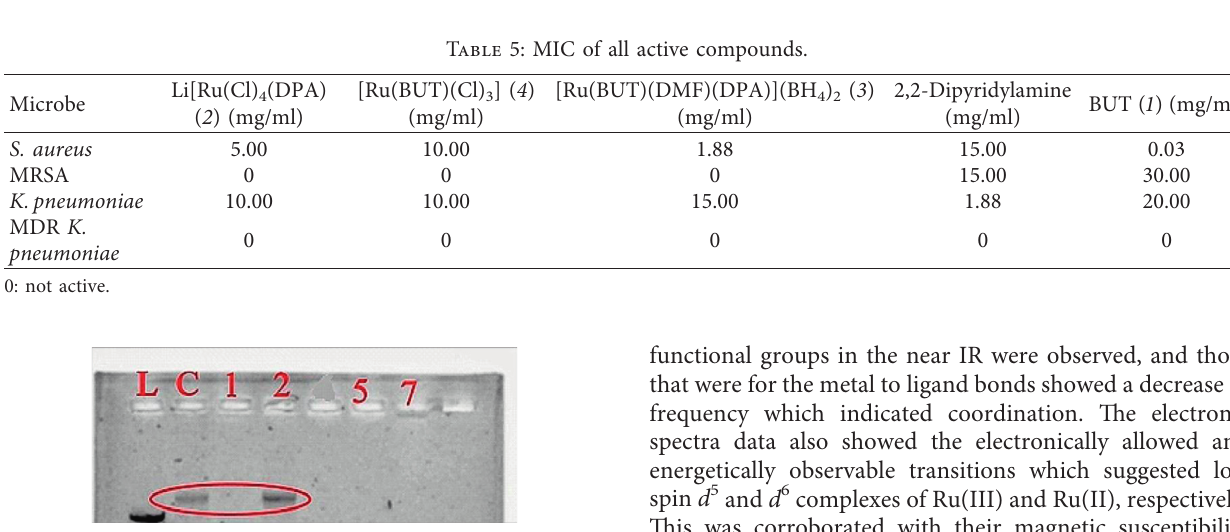
Figure 2: DNA cleavage analysis on 0.8% agarose gel. Lane L : 1 kb ladder; C : control DNA; 1 : complex 2; 2 : BUT; 5 : complex 4; 7 : complex 3.